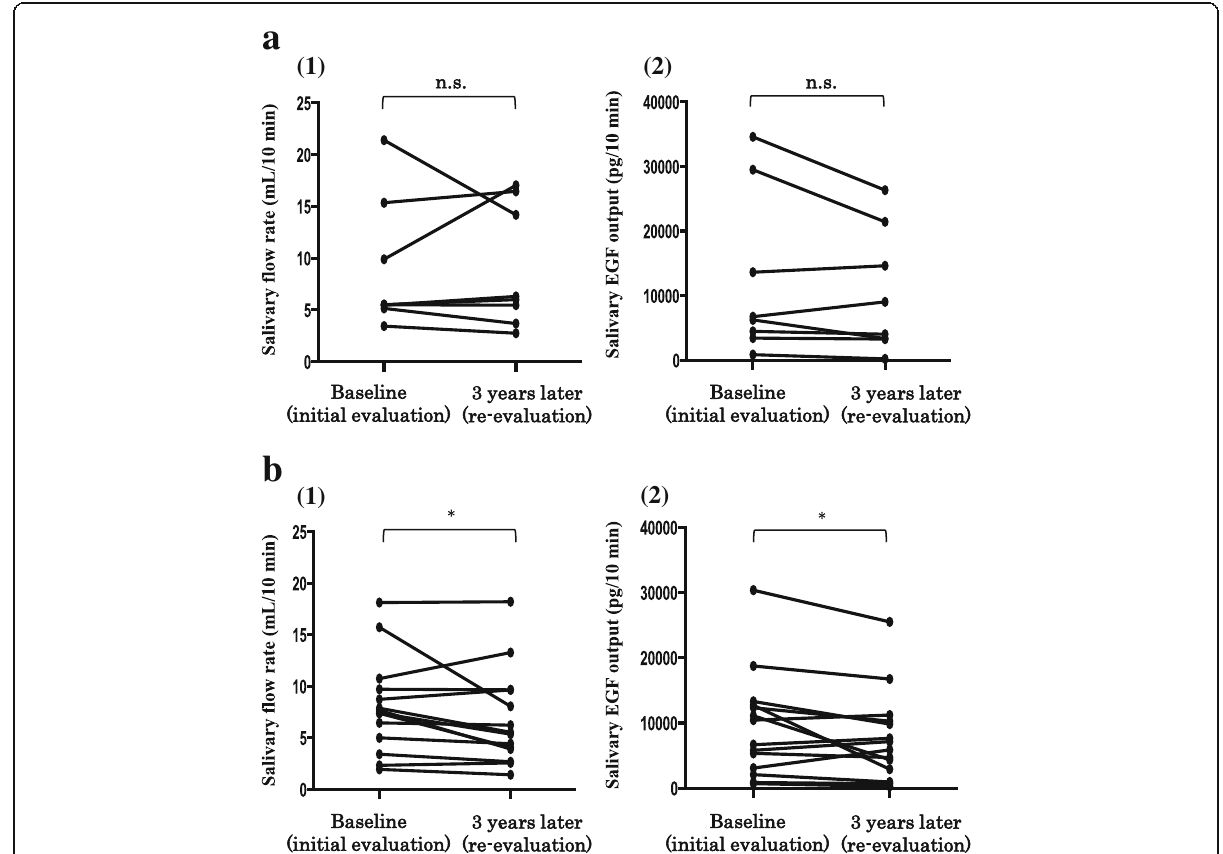
Fig. 4 Changes in the salivary flow rate and salivary epidermal growth factor (EGF) output according to the extent of changes in the Oral Health Impact Profile (OHIP)-14 score at 3-year re-evaluation. a Patient group in which the OHIP-14 score decreased or did not change (non-exacerbation group). b Patient group in which the OHIP-14 score increased (exacerbation group). (1) Changes in the salivary flow rate. (2) Changes in the saliv- ary EGF output. Statistical analysis was performed using the Wilcoxon signed-rank test. * p < 0.05; n.s., not